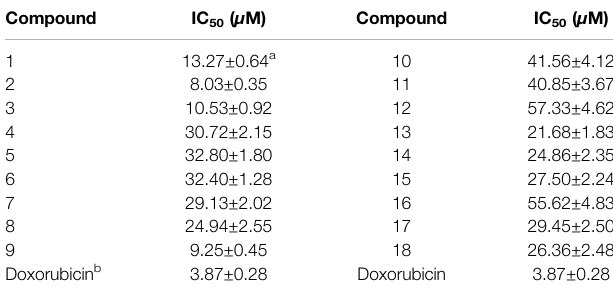
TABLE 3 | In vitro cytotoxic activity of the compounds (1 – 18) against HL-60 cell. Compound